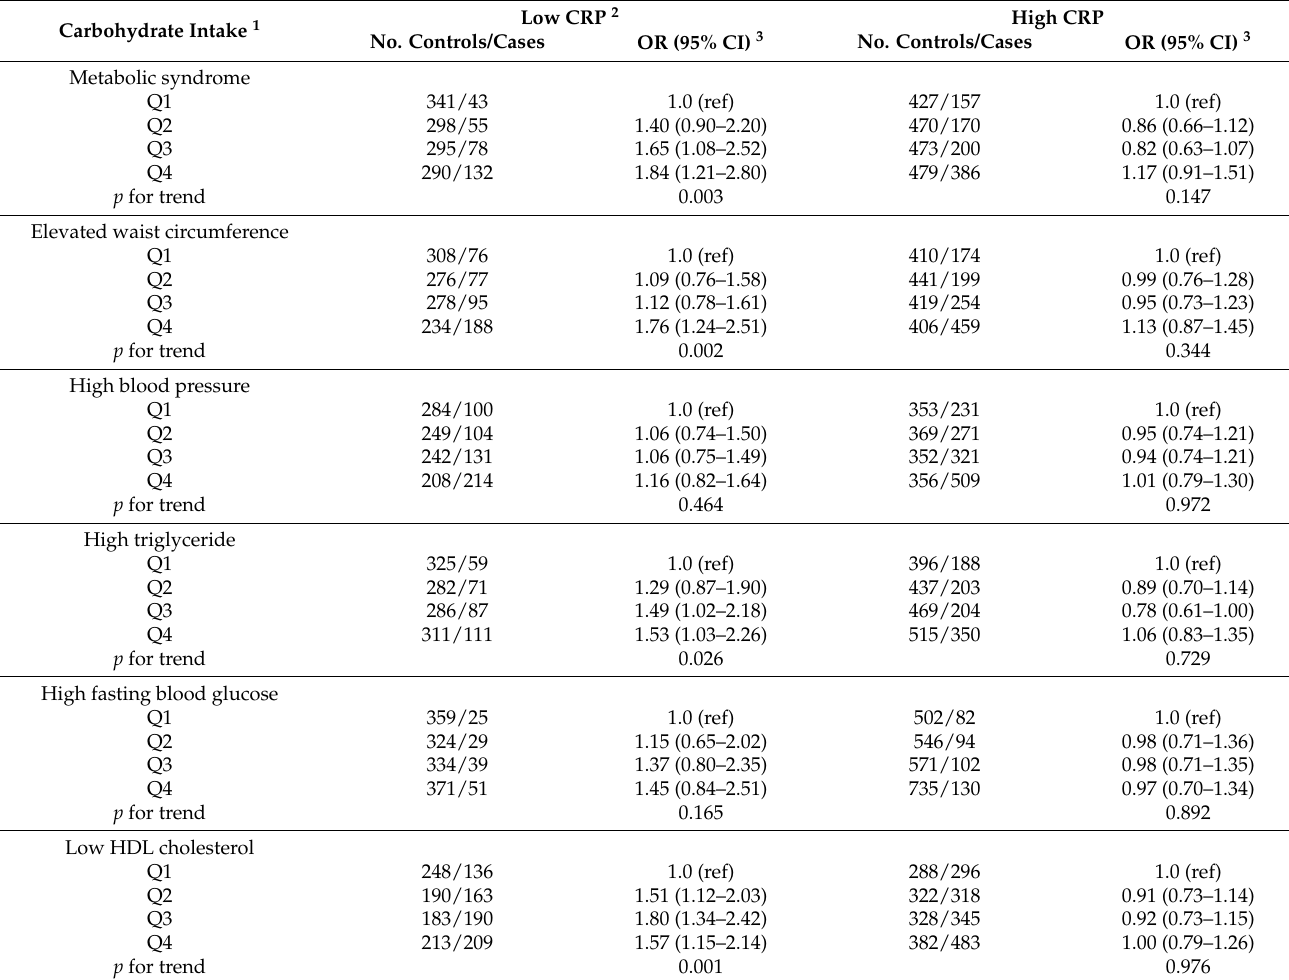
Table 3. Association of carbohydrate intake with the risk of metabolic syndrome and its components, stratified by CRP level. Low CRP 2 High CRP Carbohydrate Intake 1 No. Controls/Cases OR (95% CI) 3 No. Controls/Cases OR (95% CI) 3 Metabolic syndrome